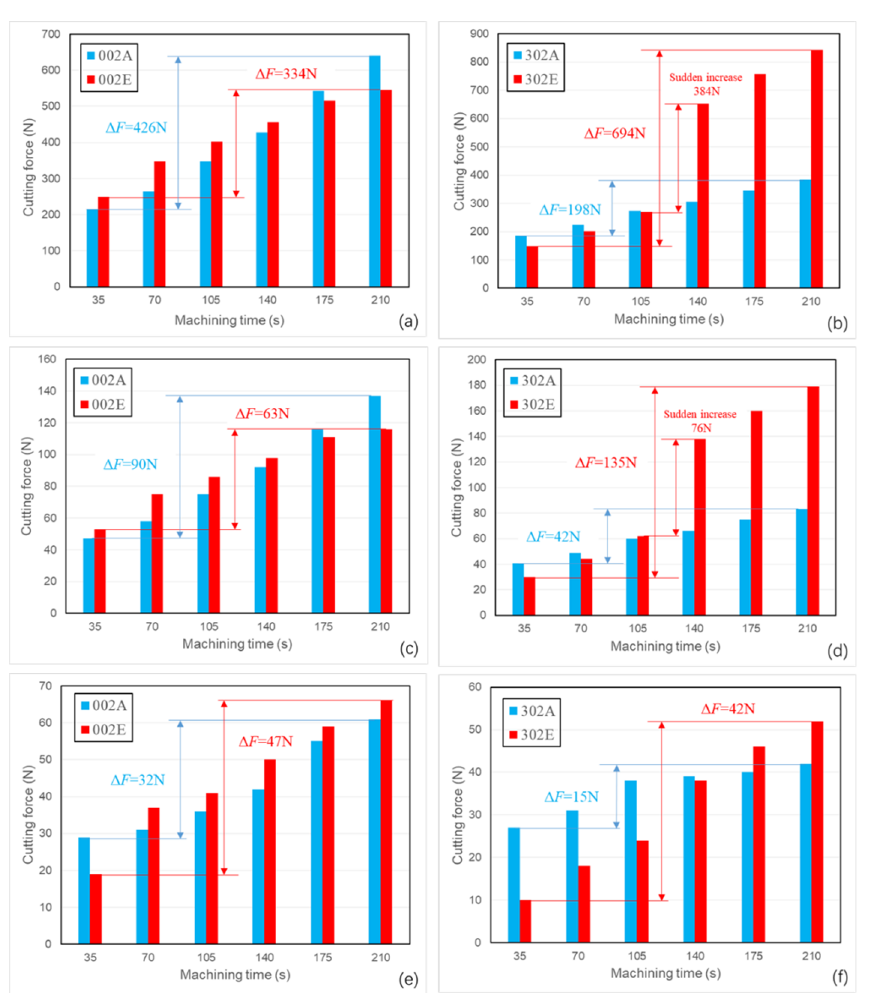
Figure 8. The change of cutting forces when using different PCD tools: ( a , b ) main cutting force, ( c , d ) feed force, and ( e , f ) thrust force.